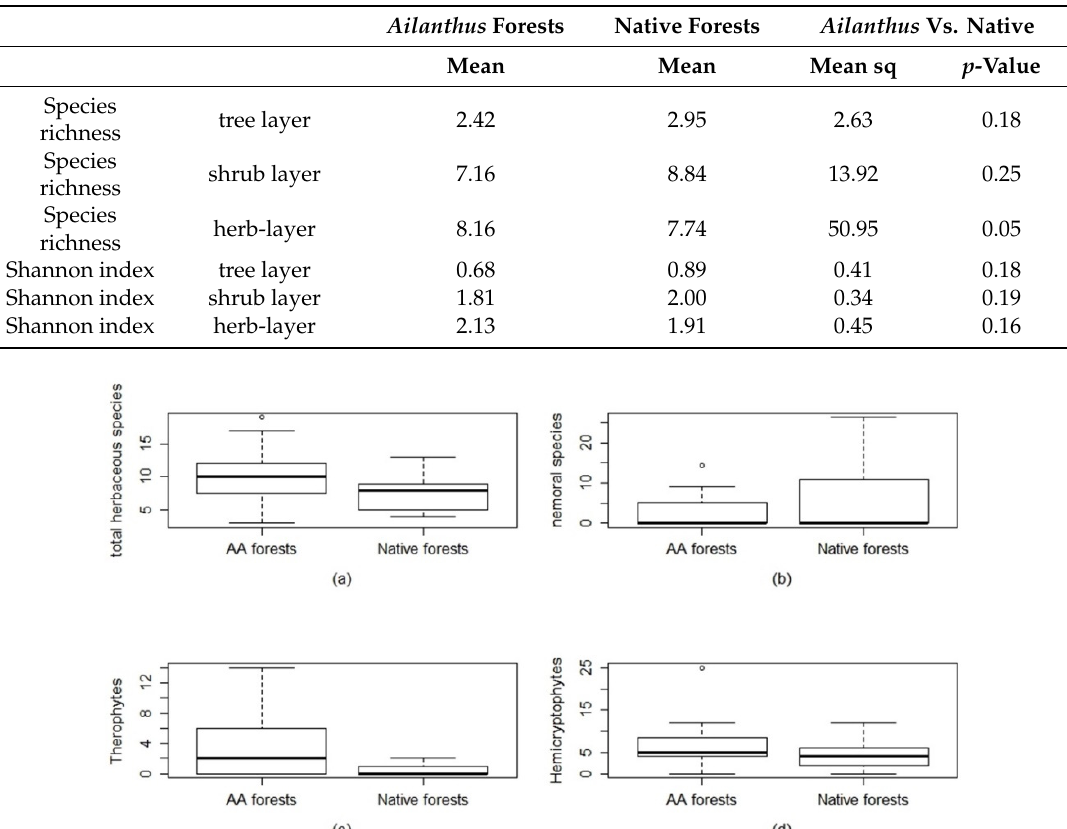
Table 1. Comparison of the vegetation layers. Mean values of the species richness and Shannon diversity index relative to the A. altissima and native forests for the tree, shrub, and herbaceous layers. Results from the ANOVA test between the two groups and the significance level is given. Significant values are in bold.